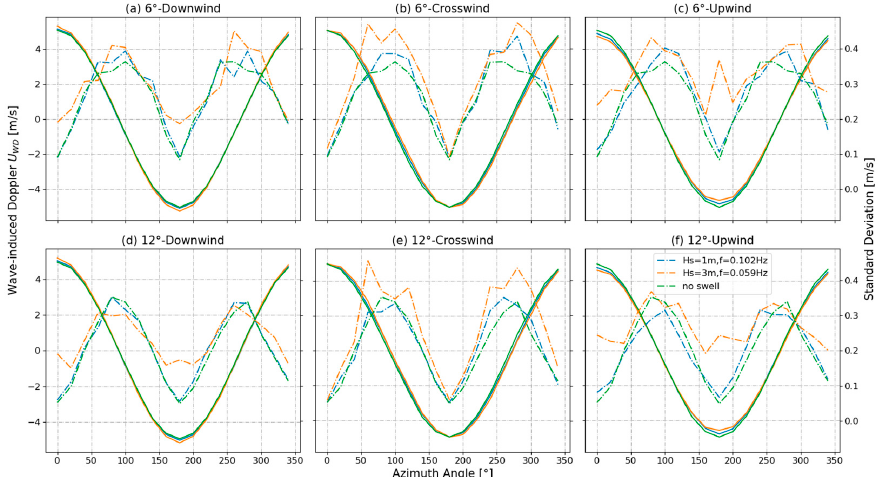
Figure 18. Variation in U WD values and standard deviations with azimuth angle, swell scale (B2 and D2 according to Table 2), and radar incidence angle (6° and 12°) with medium wind speed (10 m/s) and swell in the downwind, crosswind, and upwind directions. The y-axis on the left refers to U WD values, which are shown in colored solid lines. The y-axis on the right refers to U WD standard deviations, which are shown in colored dashed lines.